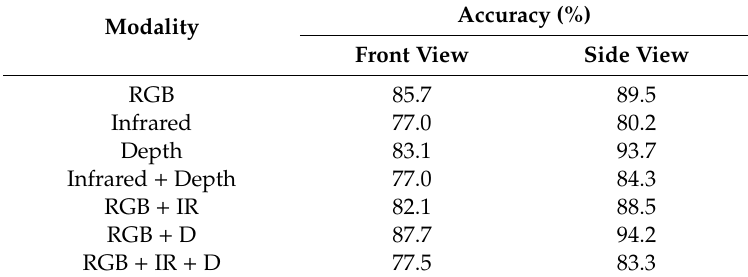
Table 4. Recognition accuracy with different image modality combinations.